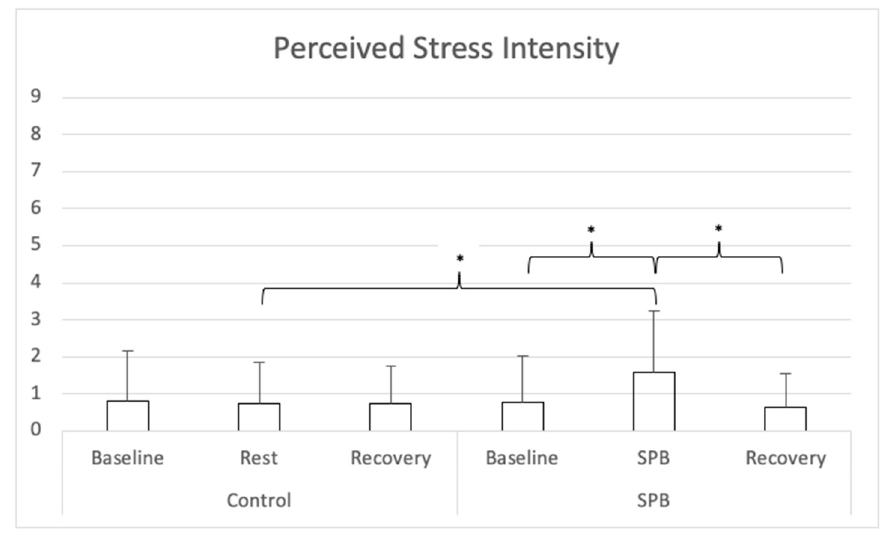
Figure 2. Perceived Stress Intensity. Note: SPB: Slow-paced breathing; * p < 0.006 (Bonferroni correction).